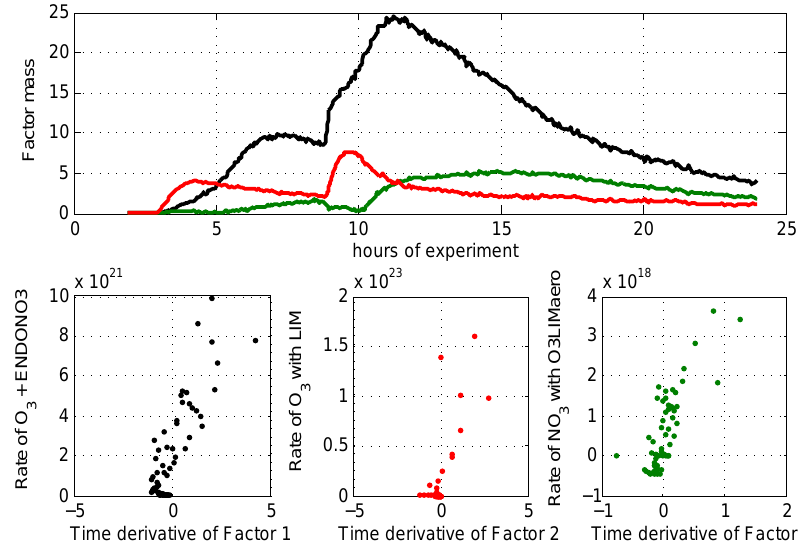
Fig. 9. Summary of PMF results. Upper panel: measured mass in each factor (1: black, 2: red, and 3: green). After these three mass factors, residuals were below +/ − 2% for the entire experiment. Lower panels: correlation plots of the time derivative of each factor with the rate of the best correlated chemical process.